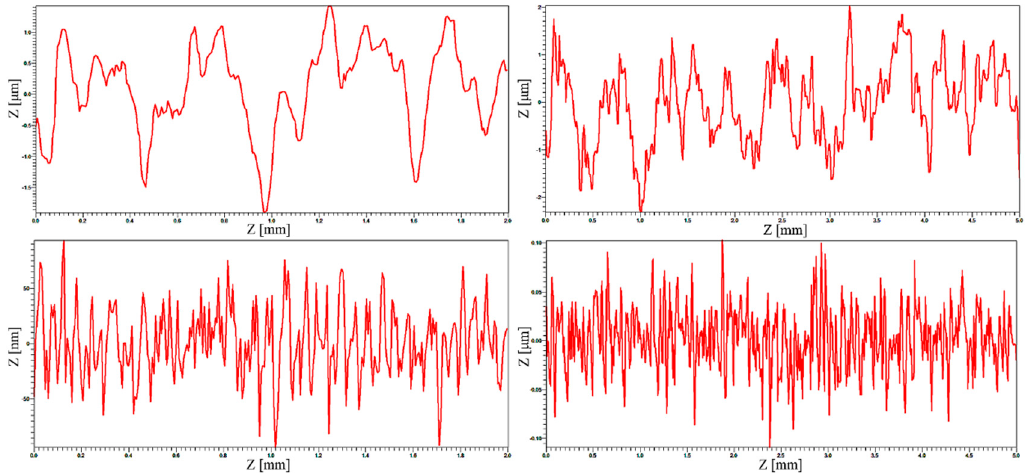
Figure 4. Surface profile curves of typical PU2 and PU4 films extracted from the above Figure 3. Upper images are corresponding to PU2 and lower images to PU4 film.